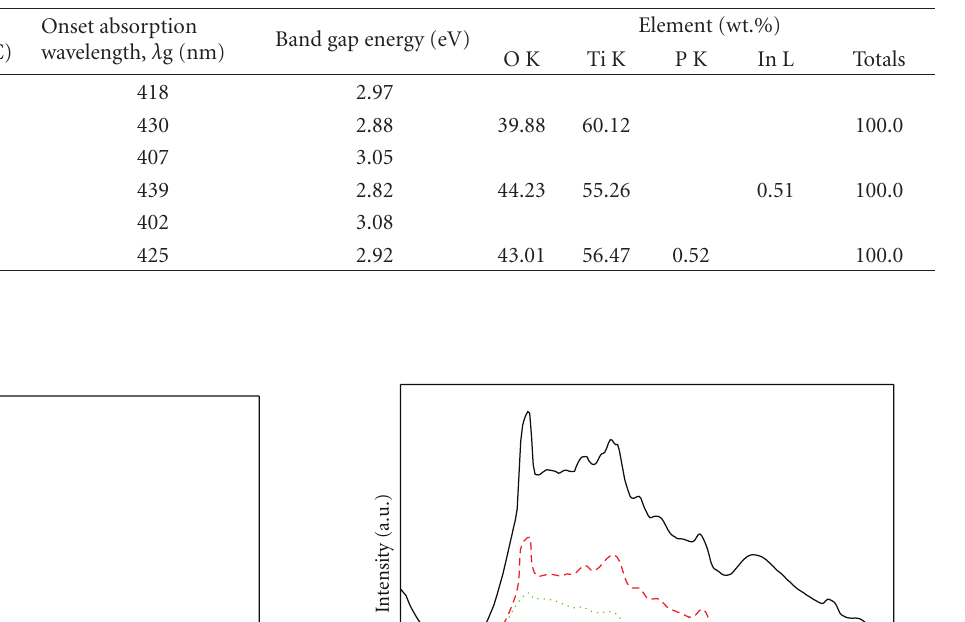
Table 1: Summary of the onset absorption wavelengths, band gap energies, and chemical composition of 1.0 mol% In, P incorporated TiO 2 photocatalysts.